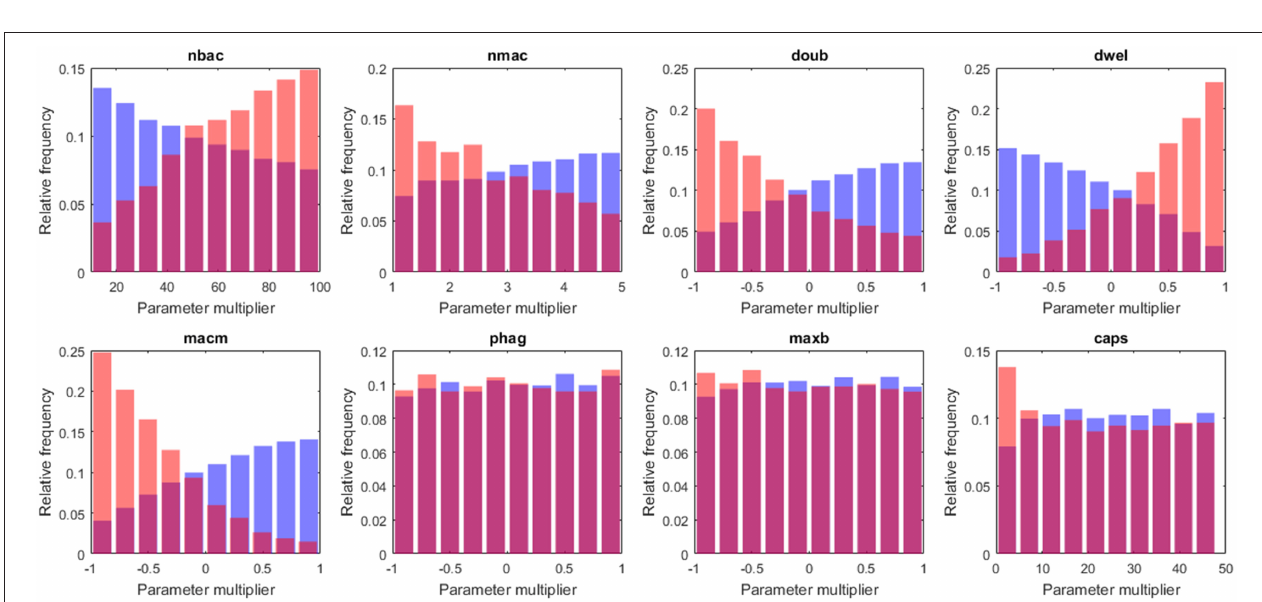
FIGURE 6 | Histograms of tissue-level parameter values: high load group in red and low load in blue. The plotted values are the factors that multiply the value of the nominal solution. The distribution of solutions for a different sample number is shown in Supplementary Material.